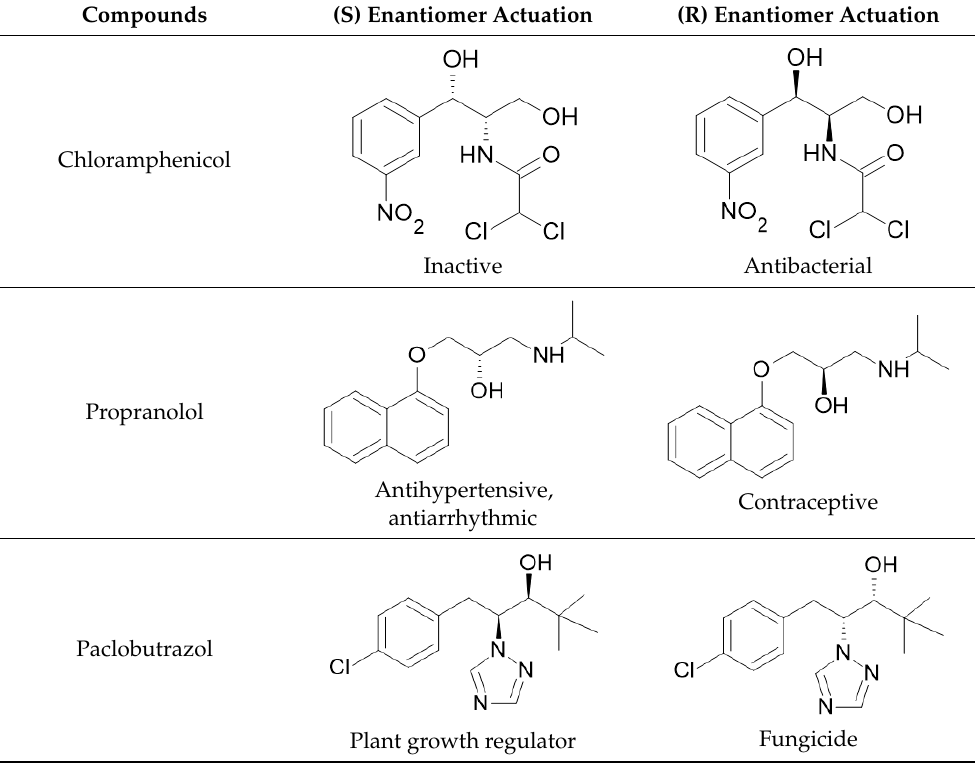
Figure 7. Perfect ( a ) and failed ( b ) connection between enantiomers and biological receptor. 4. Enantiomeric Drug Market Nearly 60% of prescribed drugs have an enantiomeric pair [16,17]. However, for a long time, it was a common practice to commercialize chiral drugs in their racemic mix- ture. Regulatory authorities have put pressure on pharmaceutical companies to sell enan- tiomeric medicaments in their pure form [2,4]. Ethambutol was the first drug to be com- mercialized as a single enantiomer in 1961 [18]. Since then, the number of enantiomers sold in their pure form has increased year after year. In 1994, only 20% of the top selling drugs were enantiomers in their pure form [4]. In 2005 this number was already 37% [19] and currently it is over 50% [20]. This increase is justified to regulators that increasingly